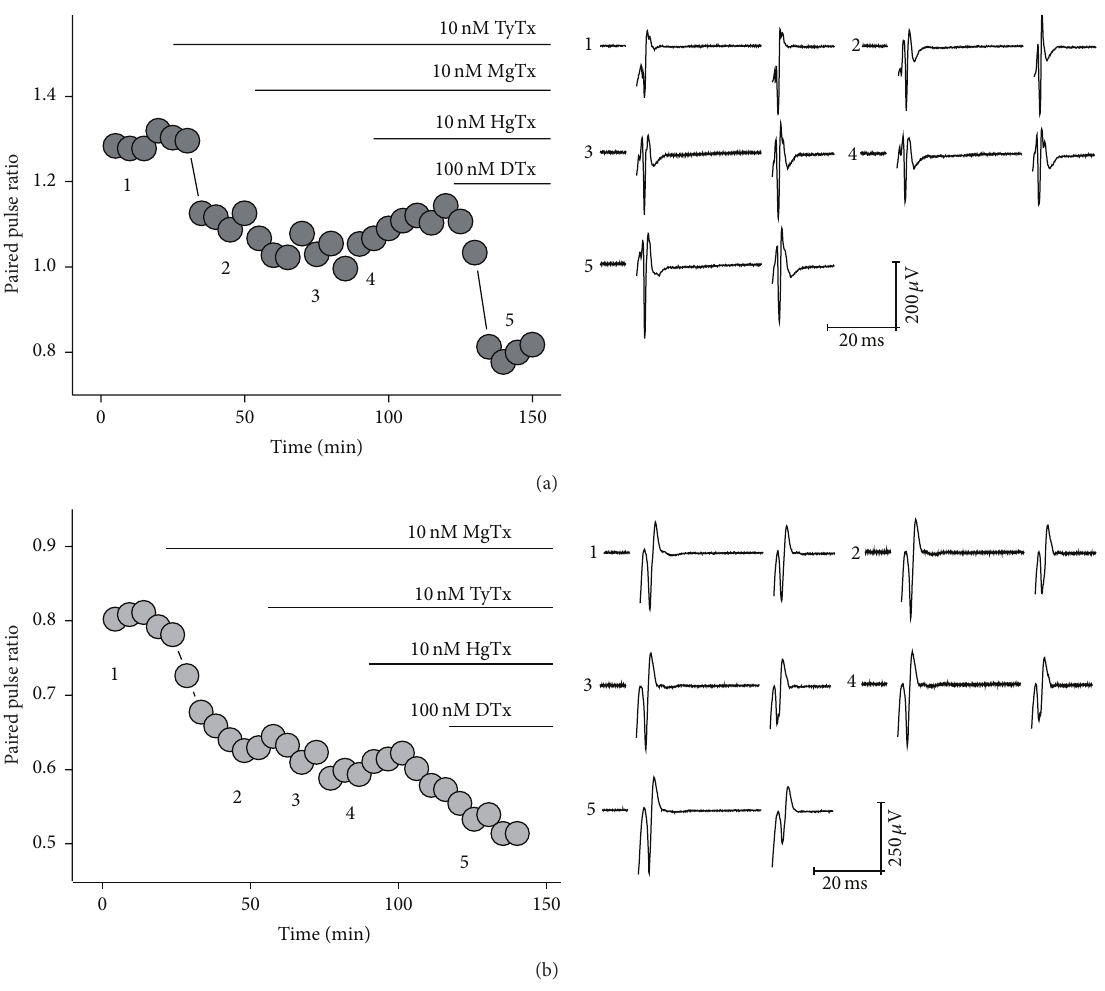
Figure 6: Additive effects of K V 1 specific-isoforms blockers on PPR. This figure shows the recordings from a single slice sequentially exposed to several K V blockers. An additive effect was observed on PPR (left panels) and traces taken at the times indicated on the PPR plot (right panel). In (a) K V 1.2 blockage with tityustoxin (TyTx) induces a reduction in PPR that remains with little change despite addition of K V 1.2/K V 1.3-blocker margatoxin (MgTX) and K V 1.1/K V 1.2/K V 1.2-blocker hongotoxin (HgTx); however addition of K V 1.2/K V 1.3/K V 1.6- blocker dendrotoxin (DTx) produced a second reduction of PPR. (b) Addition of MgTx to block K V 1.2/K V 1.3 channels produced a drop in PPR comparable to that observed with TyTx. Further addition of TyTx and HgTx did not alter PPR. Once again DTx induces a second steep